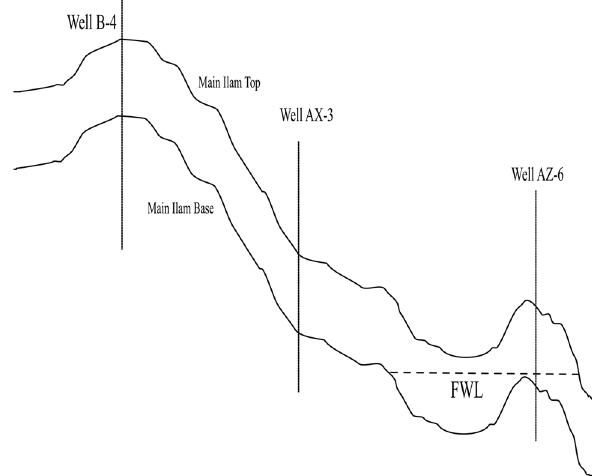
Fig. 7 Presence of perched water in peripheral wells in Fields A and C. Dashed lines represent a high gradient in the main reservoir which are not the regional FWL. An oil column in Well A-X1 has been established which is below the perched water depth in other wells